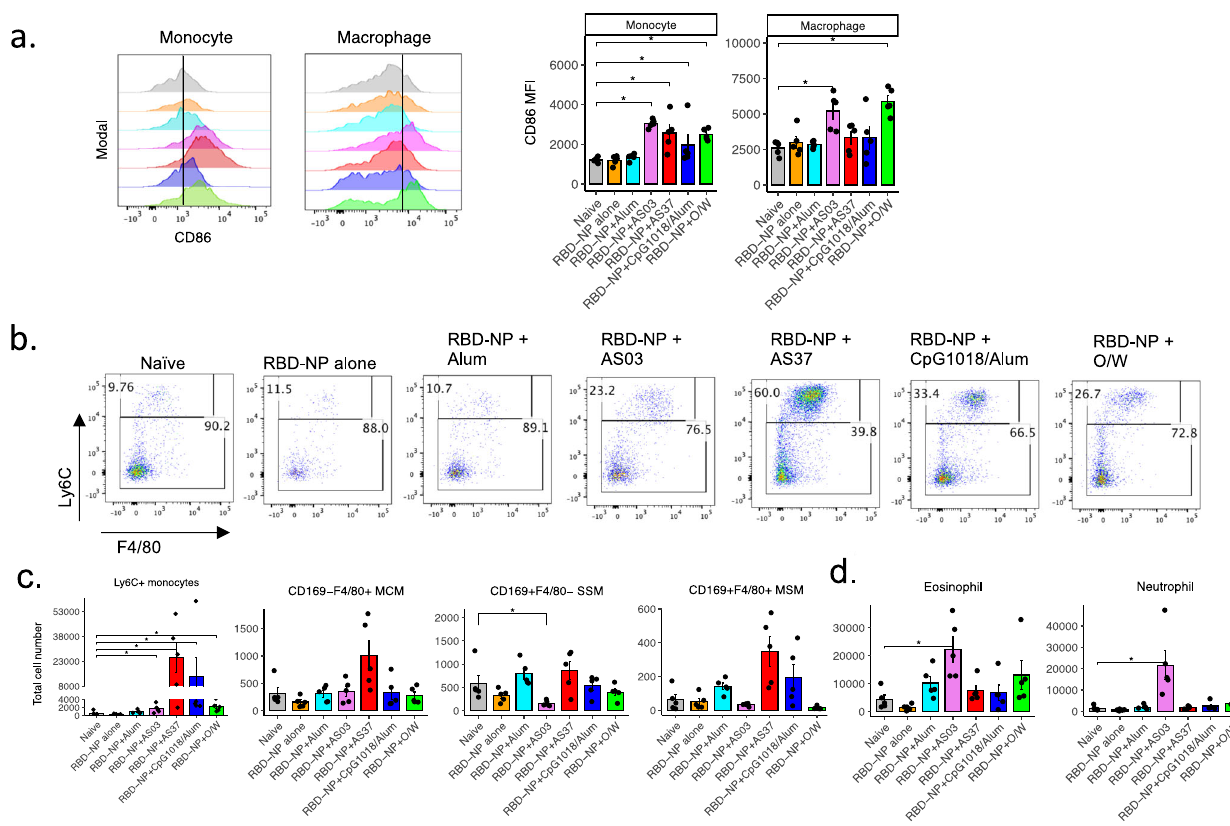
Fig. 5 Monocyte, macrophage, and granulocyte responses to immunization with RBD-NP and adjuvants. a CD86 MFI of monocytes and macrophages in the draining iliac lymph nodes 24 h post-immunization. b Representative fl ow cytometry plot for Ly6C + monocytes. c Absolute cell numbers of monocytes and macrophage subsets ( c ) and granulocytes ( d ). Data representative of 3 independent experiments with n = 5 mice per group. P -values: * denotes p < 0.0332, ** p < 0.0021, *** p < 0.0002, and **** p < 0.0001. Error bars indicate mean ± SEM in all